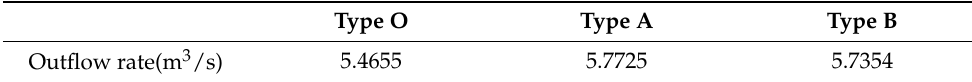
Table 2. The outflow rate of three